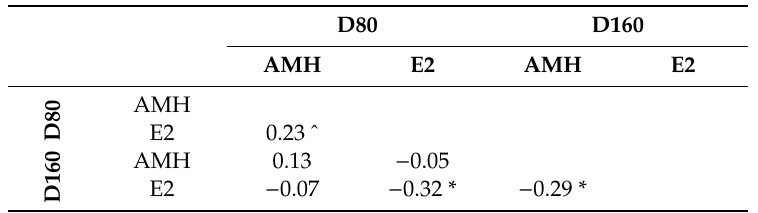
Table 3. Pearson’s correlation coe ffi cients between ovarian hormones at 80 and 160 days of age (D80 and D160,